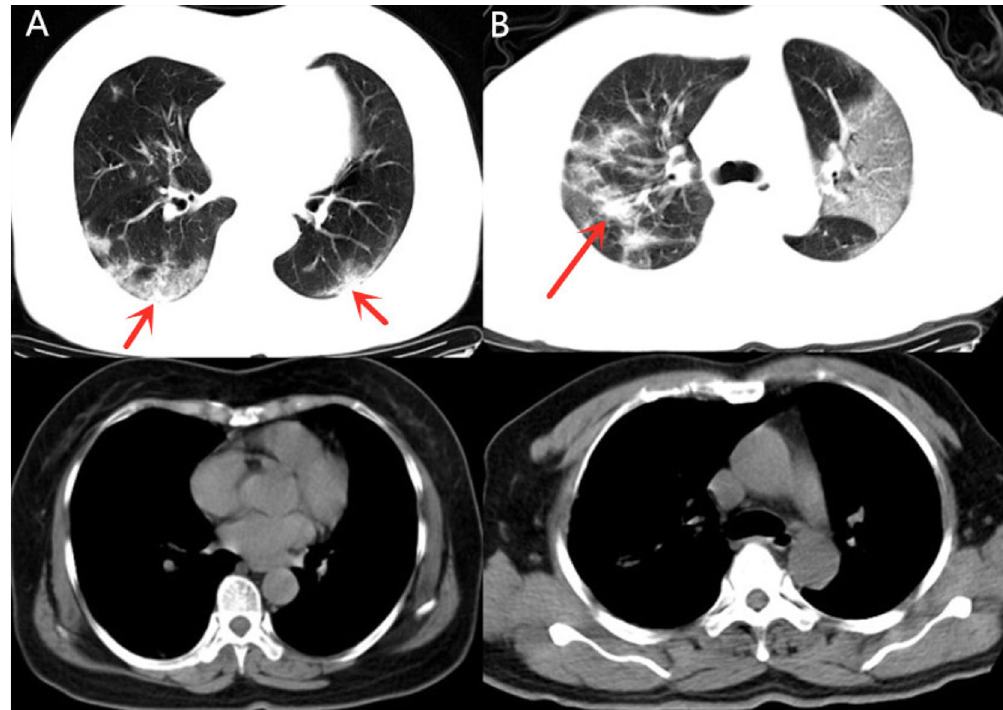
Figure 4. Example of patients with CT demonstrated as GGO > consolidation in Group 1. ( A ) 65-year-old female with confirmed COVID-19 pneumonia in Group 1 who had hospitalization time of 12 days. CT